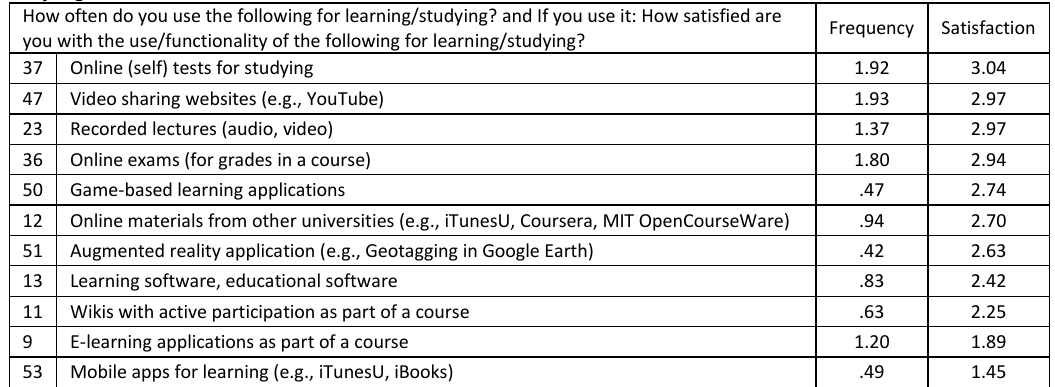
Table 8. Means of students’ answers to the questions: How often do you use the following for learning/studying? and If you use it: How satisfied are you with the use/functionality of the following for